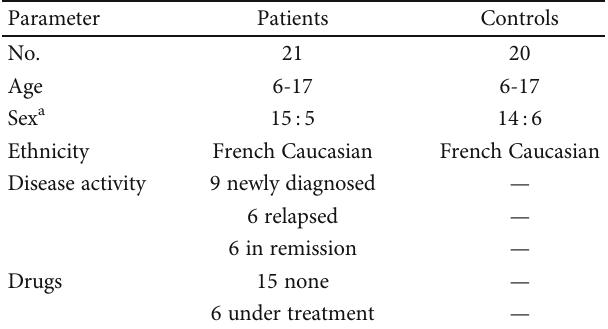
a Male:female ratio. The newly diagnosed patients had not received any treatment. The relapsed patients were previously treated with azathioprine, prednisone, anakinra, and natalizumab in di ff erent combinations. However, they were currently not receiving any treatment. The patients